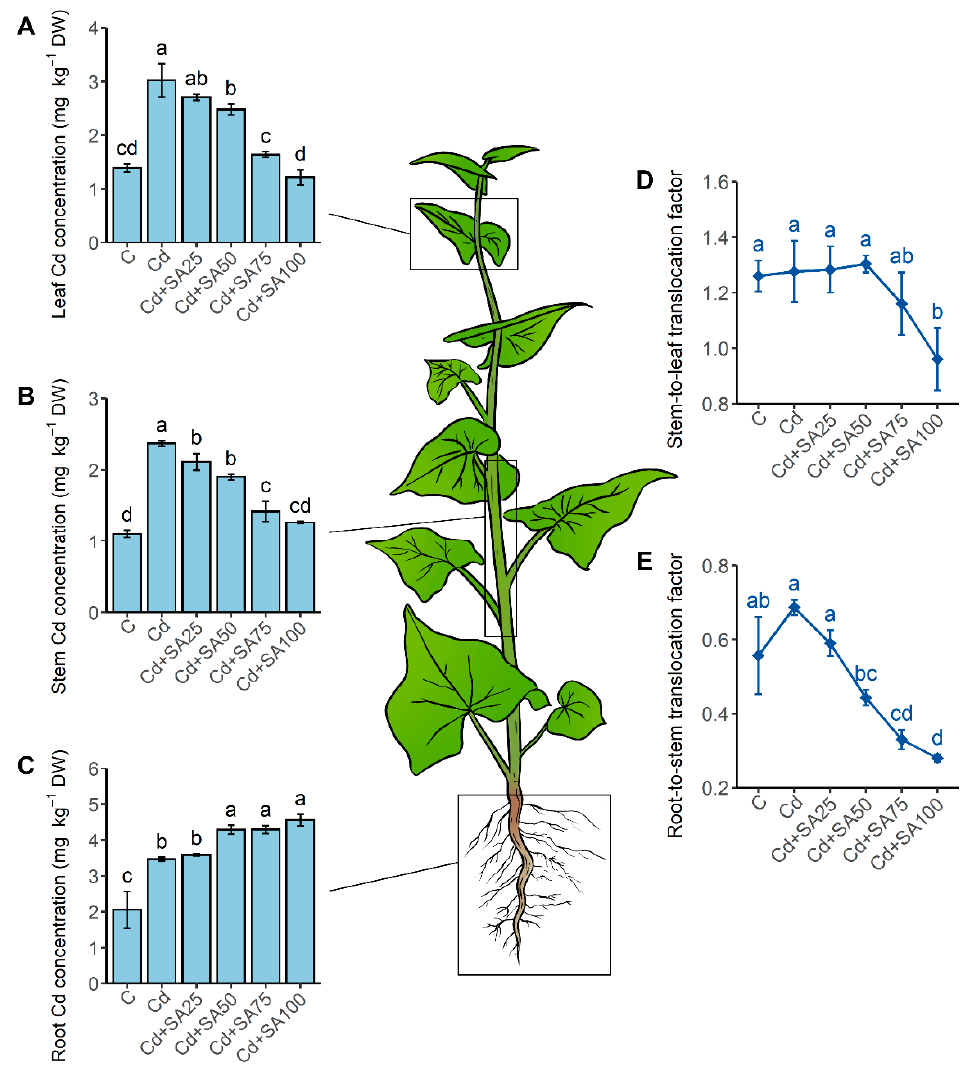
Figure 2. Cd concentrations in the leaf ( A ), stem ( B ), and root ( C ) of Tartary buckwheat cultivated in Cd-contaminated soil treated with different concentrations of salicylic acid and the corresponding stem-to-leaf ( D ) and root-to-stem ( E ) translocation factor. The Cd concentration was measured in mg Cd per kg dry weight of the plant sample (mg kg − 1 DW). The root-to-stem translocation factor is the ratio of stem Cd concentration to root Cd concentration, and the stem-to-leaf concentration is the ratio of leaf Cd concentration to stem Cd concentration. C denotes the control plant group cultivated in the uncontaminated soil without any treatment. Cd denotes the group of plants cultivated in the soil with 2.0 mg kg − 1 Cd contamination without SA treatment. Cd + SA25, Cd + SA50, Cd + SA75, and Cd + SA100 denote the plant groups cultivated in the soil with 2.0 mg kg − 1 Cd contamination treated with 25, 50, 75, and 100 µmol L − 1 salicylic acid, respectively. Different lowercase letters denote significant differences between the treatment groups ( p < 0.05).